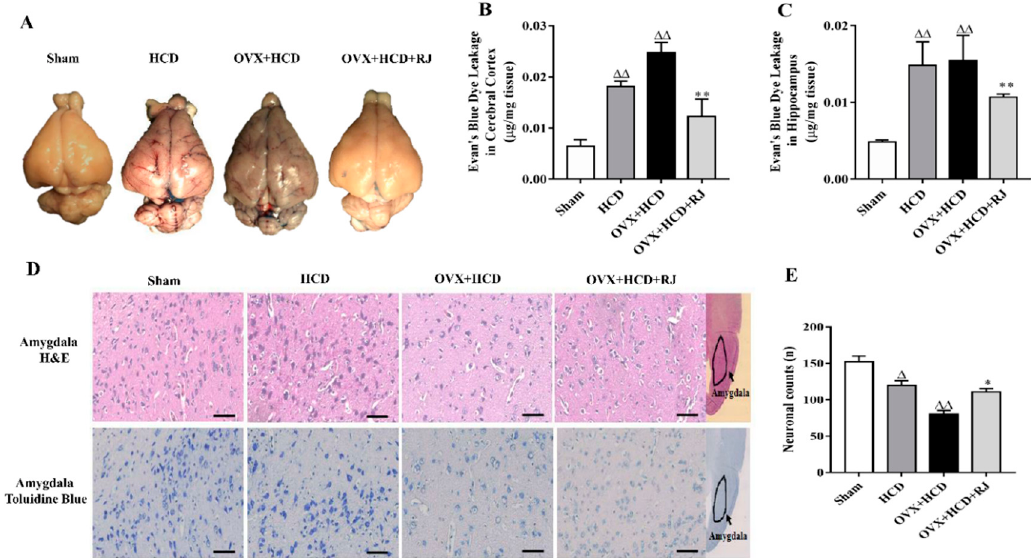
Figure 1. Royal jelly (RJ) ameliorated blood–brain barrier (BBB) and reduced neuronal loss in ovariectomized cholesterol-fed rabbits. ( A ) Representative photos of Evans blue staining in rabbit brains, and Evan’s blue dye leakage in the cerebral cortex ( B ) and hippocampus ( C ). ( D ) Representative photos of H&E staining and toluidine blue staining in the amygdala of rabbit brain, scale bar = 50 µ m, and neuronal counts per view (40 × ) in the amygdala areas among the four groups ( E ), n = 4 rabbit per group. Data are presented as mean ± SEM. Compared with Sham group, ∆ P < 0.05, ∆∆ P < 0.01; Compared with OVX + HCD group, * P < 0.05, ** P < 0.01.2.4. RJ enhanced heart rate variability (HRV) and baroreflex sensitivity (BRS) in OVX cholesterol-fed rabbits.